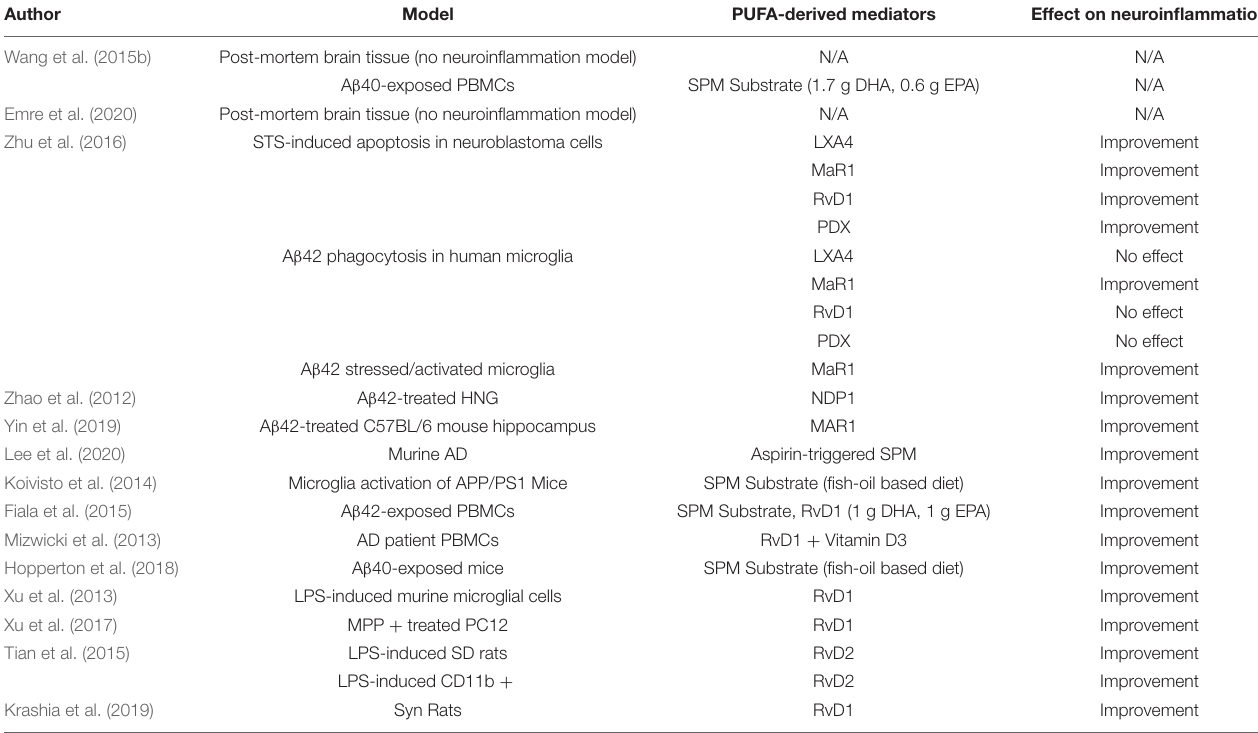
TABLE 1 | Impact of PUFA-derived lipid mediators on neuroinflammation in in vitro and in vivo neurodegenerative disease